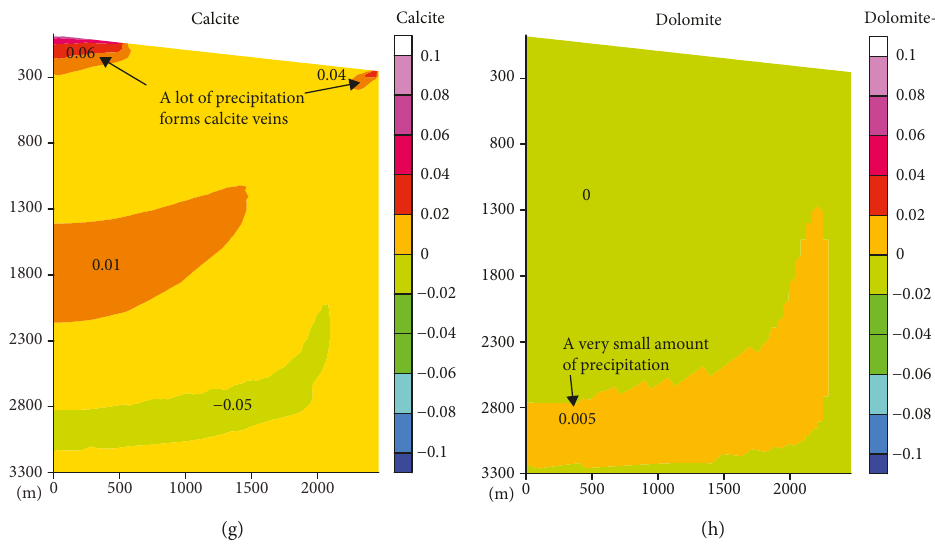
Figure 5: Changes of mineral abundance in volume fraction (dimensionless) after a simulated period of 8000 years, with positive values indicating precipitation and negative values indicating